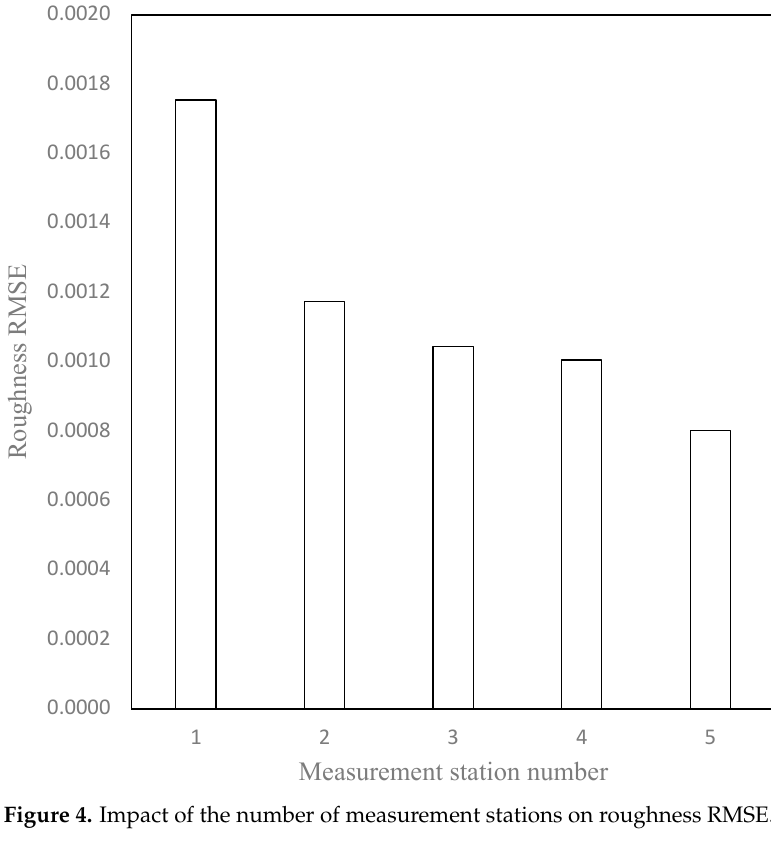
Figure 4. Impact of the number of measurement stations on roughness RMSE.